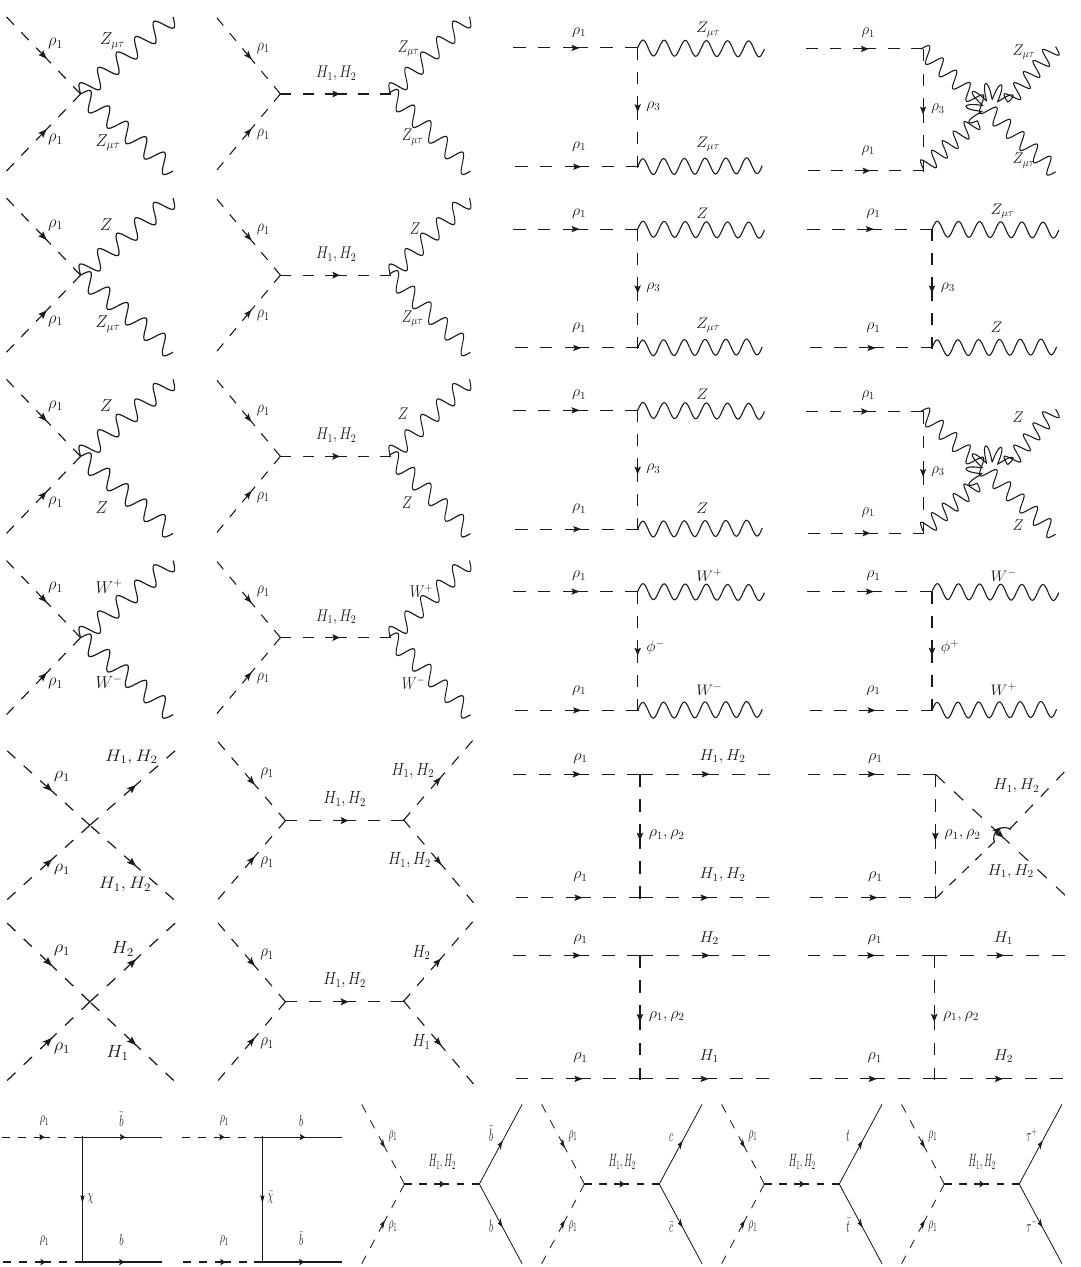
Figure 7 . Feynman diagrams of dark matter annihilation channels contributing signi(cid:12)cantly to the freeze-out